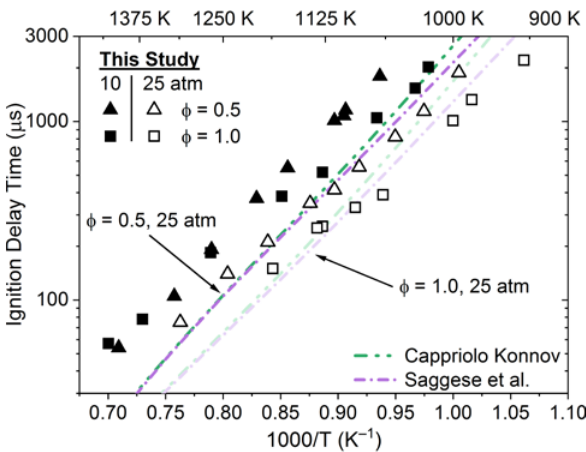
Figure 8. Comparison of all ignition delay time data collected herein. Model comparisons by the Capriolo and Konnov and the Saggese et al. models are shown for the 25-atm experiments.